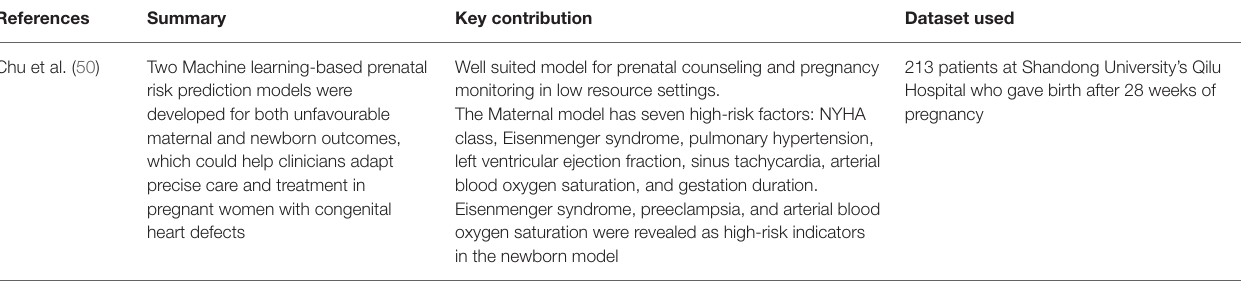
TABLE 5 | Summary of approaches used to predict risk of complications in women with congenital cardiac disease.